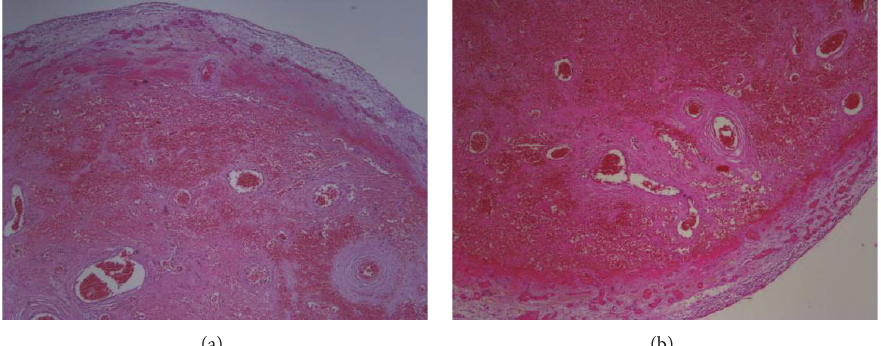
Figure 2: (a) Transmural necrosis and hemorrhage (H&E staining × 100 magnification). (b) Ischemic necrosis, congestion, and hemorrhage (H&E staining × 100